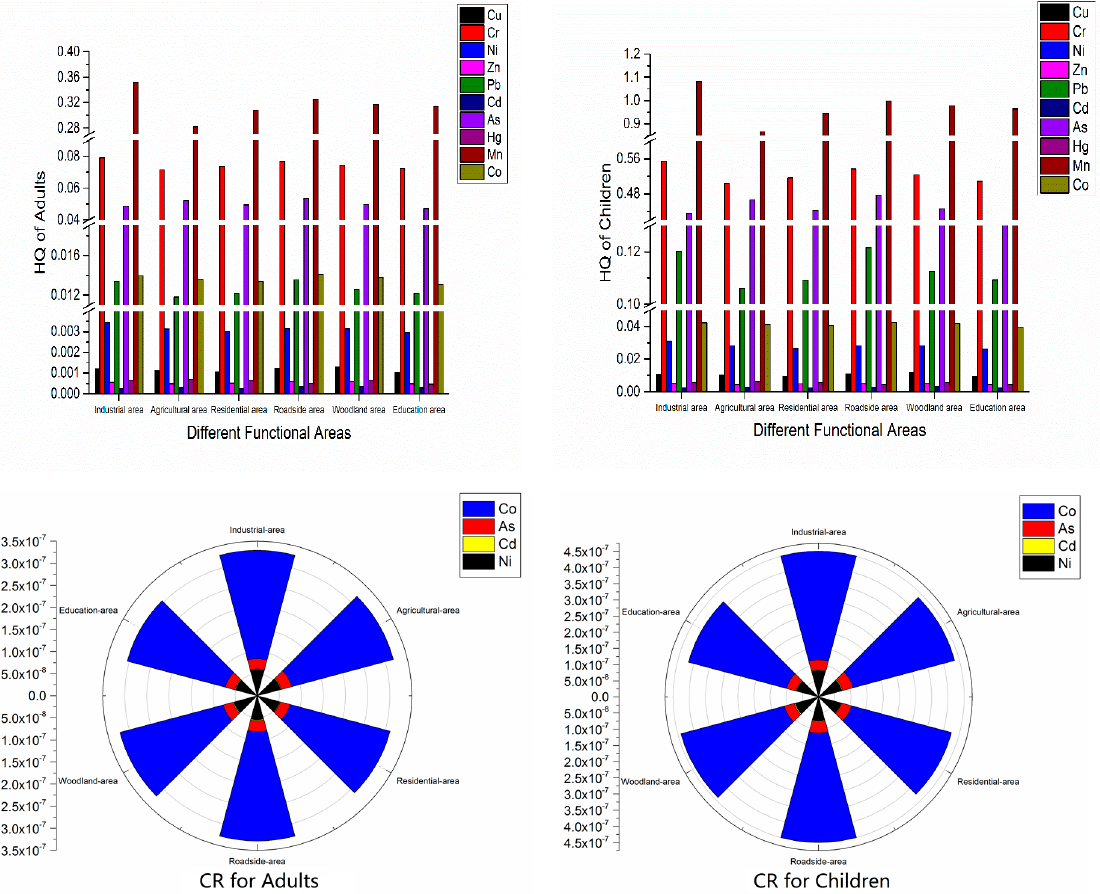
Figure 6. Column charts of the non-carcinogenic risk and wind roses of the carcinogenic risk for adults and children in the six functional areas.